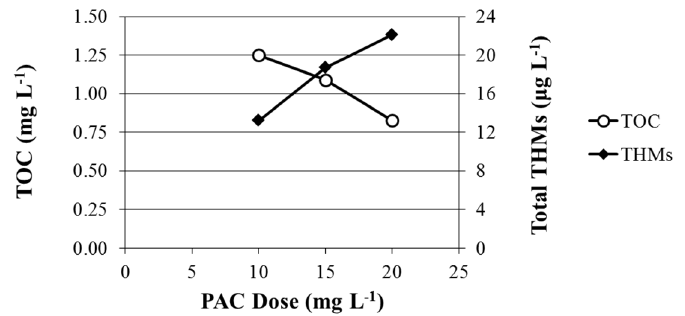
Figure 3. A plot of the powdered activated carbon optimization study; demonstrating a decrease in Total Organic Carbon (TOC) with increasing PAC dose and a simultaneous increase in Total THMs